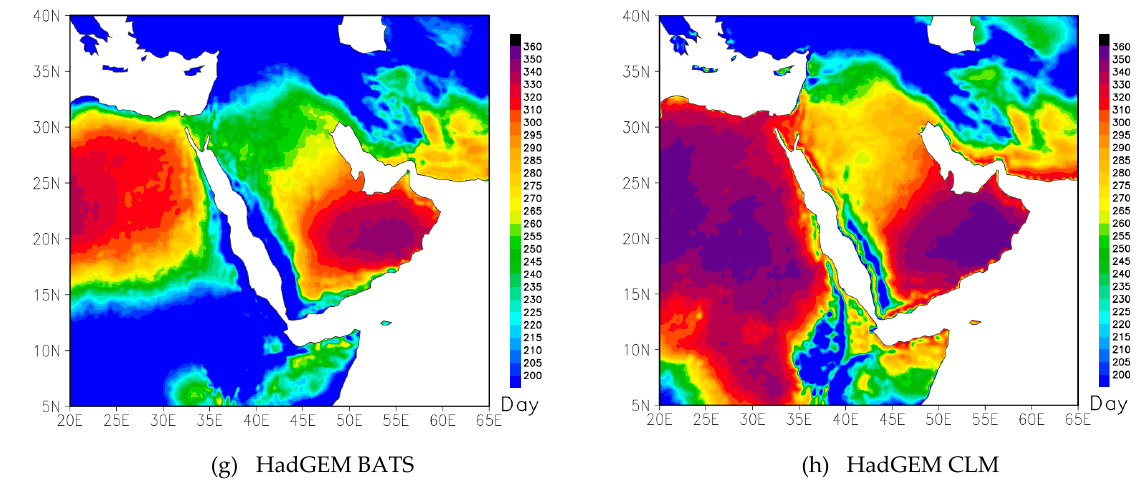
Figure 13. Spatial distribution of the annual number of annual consecutive dry days (CDD) for ( a ) ERA – Int BATS, ( b ) ERA – Int CLM, ( c ) ECHAM6 BATS, ( d ) ECHAM6 CLM, ( e ) GFDL BATS, ( f ) GFDL CLM, ( g ) HadGEM BATS, and ( h ) HadGEM CLM averaged over the period 1986–2005.